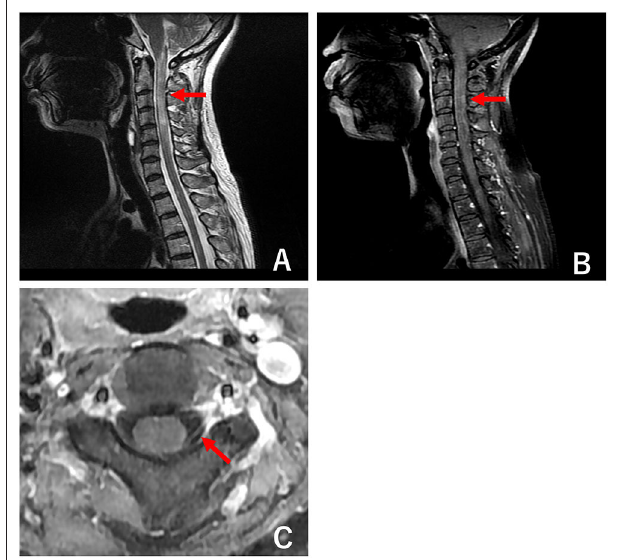
FIGURE 1 | Magnetic resonance imaging (MRI) of cervical to thoracic spinal cord. (A) Sagittal T2 MRI showing longitudinally extensive transverse myelitis (arrow) from the lower part of the medulla oblongata to C5 with marked edema. (B) Gadolinium contrast MRI of cervical to thoracic spinal cord showing mild enhancement (arrow), which represents the active lesions of myelitis. (C) Axial gadolinium contrast MRI showing active radiculopathy of the left side